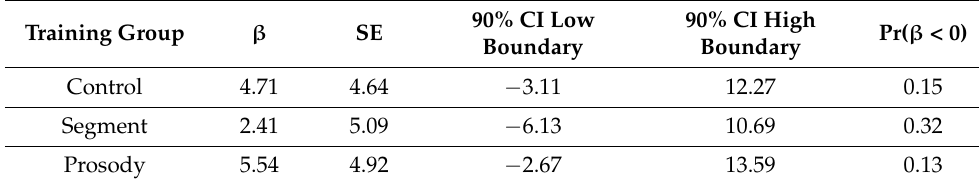
Table 9. Statistical results for closure duration distance.